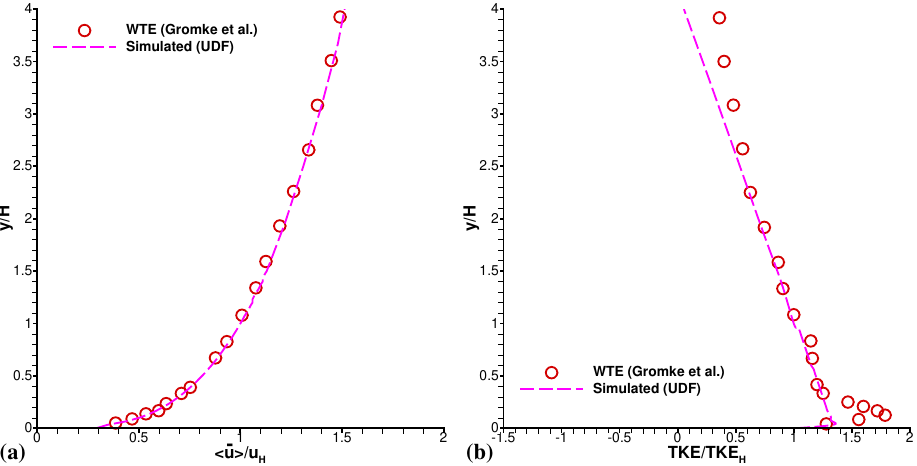
Figure 7. Characterisations in the inlet boundary condition for ( a ) Velocity and ( b ) TKE, presenting a comparison of the simulated characterisations produced by applying UDFs with the experimental characterisations.